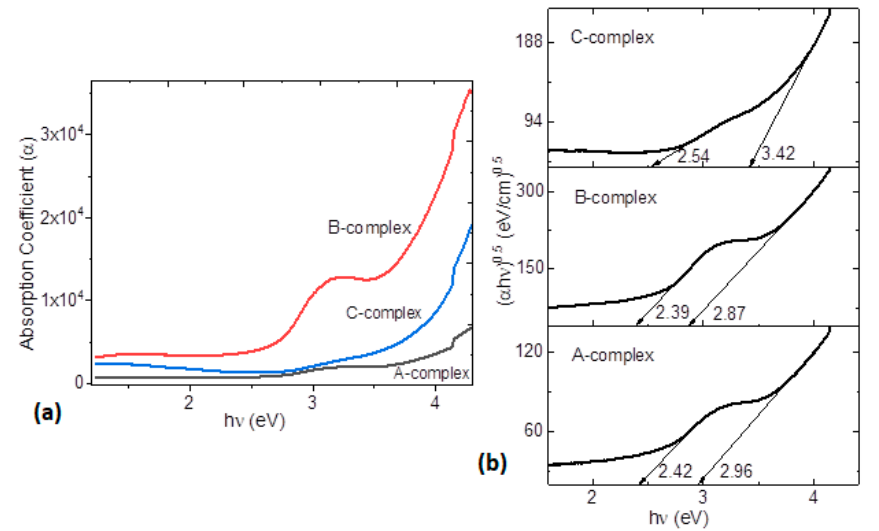
Figure 5. ( a ) Spectral behavior of absorption coefficient and ( b ) variation of ( α h ν ) 1/2 with h ν of MoO 3 /PEDOT:PSS-organotin (IV) complex films. MoO 3 /PEDOT:PSS-organotin (IV) complex